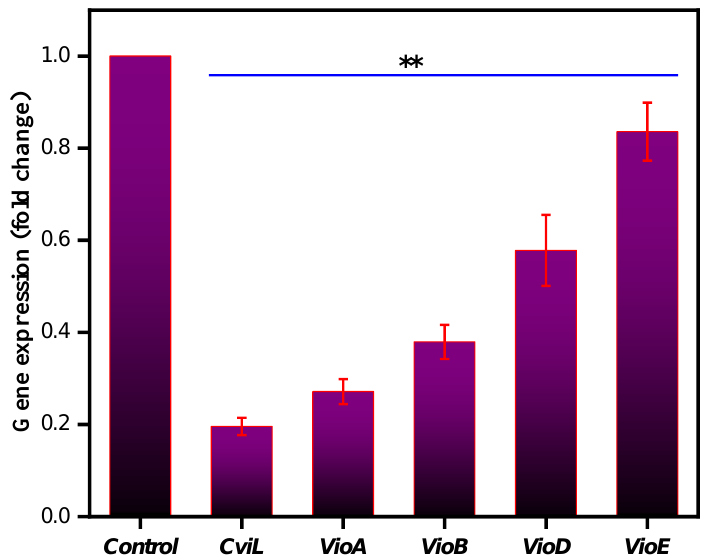
Figure 12. Relative expression of genes controlling quorum sensing in C. violaceum when treated with MIC values of the ZnO NPs. The gene expression was normalized to that of the housekeeping genes, and the expression is compared to that of untreated cells. Data represents means ± SD of three different values; ** p ≤ 0.001.